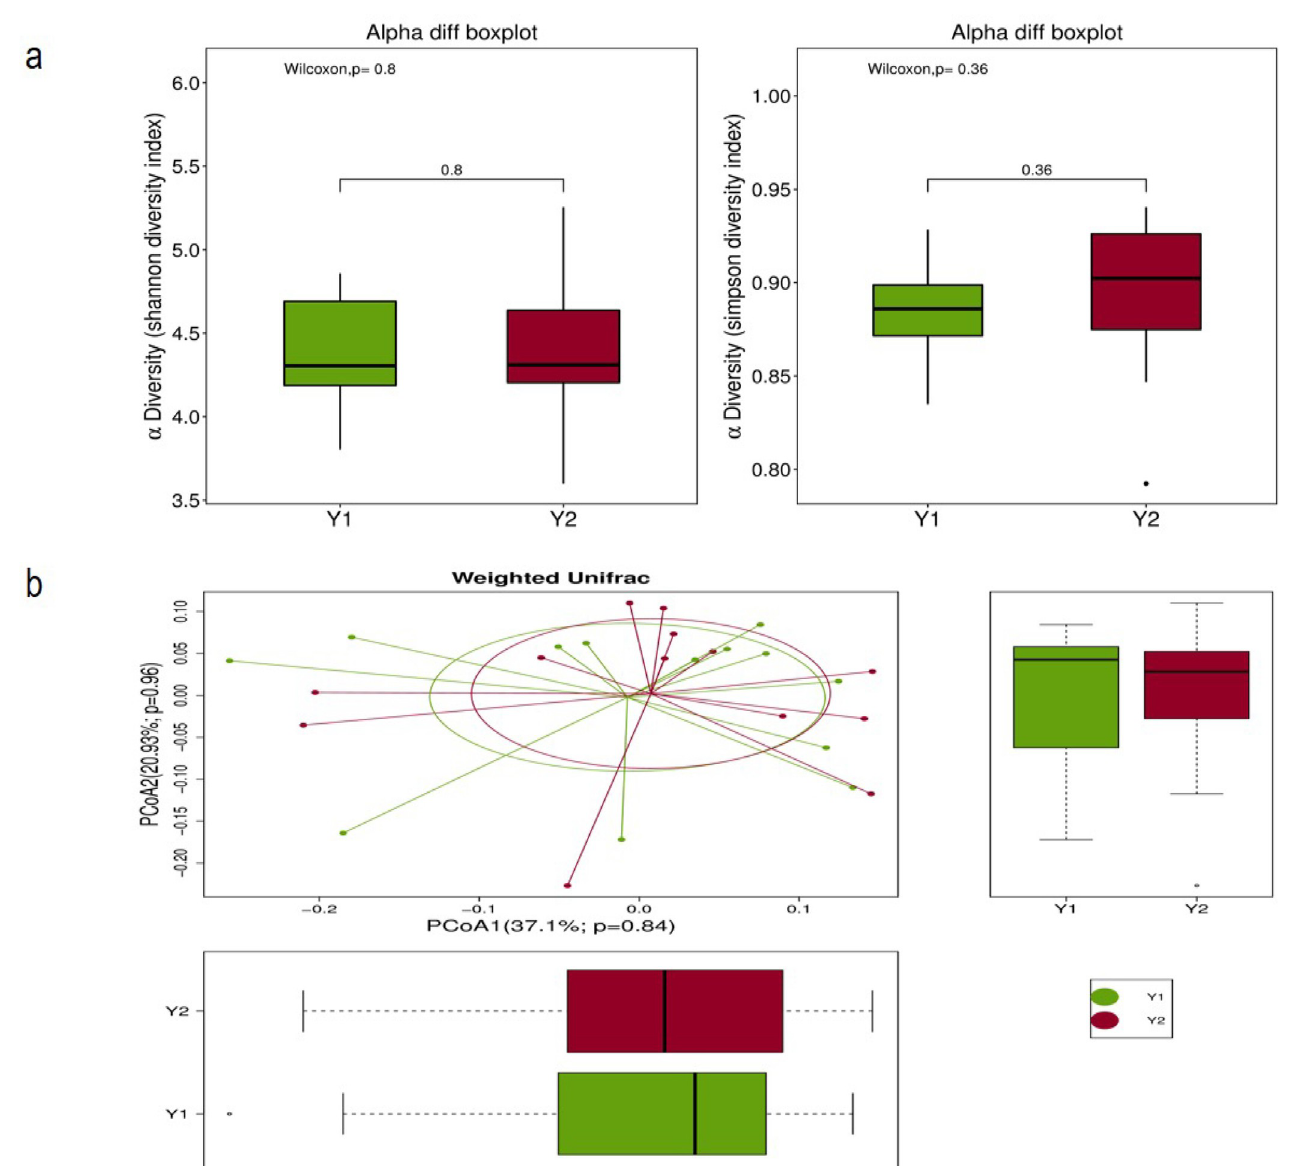
Fig 3. Changes in the gut microbiome of the effective group before and after MNT. (a) Alpha diversity between the effective group before and after therapy; (b) Beta diversity between the effective group before and after therapy: Weighted Unifrac